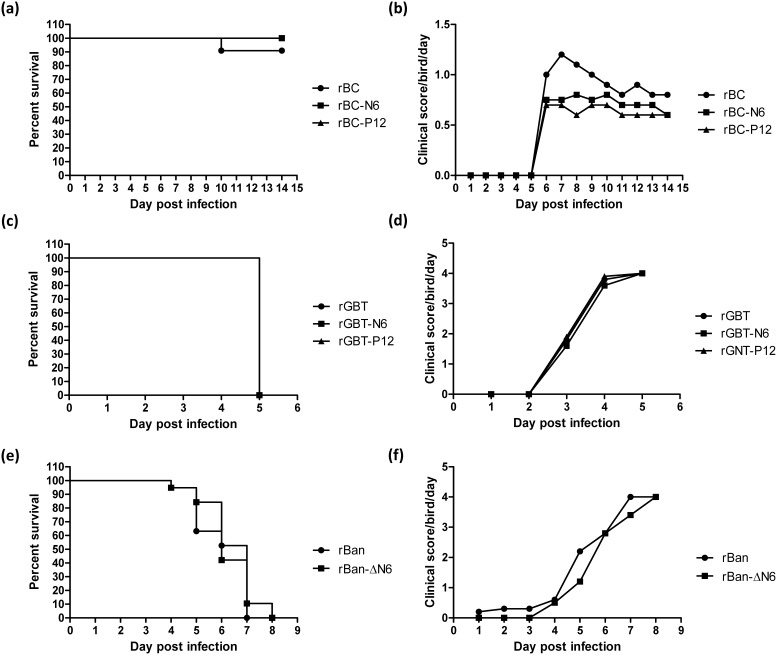
Percent survival and clinical score curves for recombinant and mutant viruses.Percent survival curve and clinical score curves for recombinant NDV strains BC (a, b), GBT (c, d) and Ban (e, f) in two-week-old chickens following oculonasal inoculation. The birds (10 per group) were clinically scored for 14 days using a scoring system for the clinical signs: 0, normal; 1, sick; 2, paralysis/twitching/wing drop; 3, prostration; and 4, death. The mean scores per group per day are plotted in the graph.